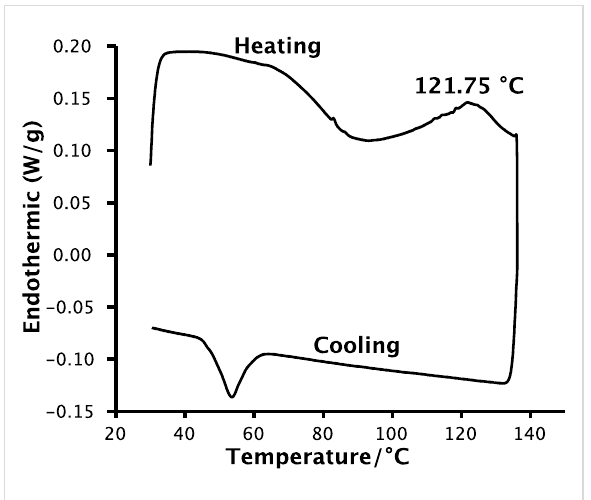
self-assembly in the gel state was driven by strong supra- molecular interactions such as hydrogen bonding. Application linear semilog plot (Figure 3), when the mole fraction of the gelator at each concentration was plotted against 1/ T gel K − 1 .